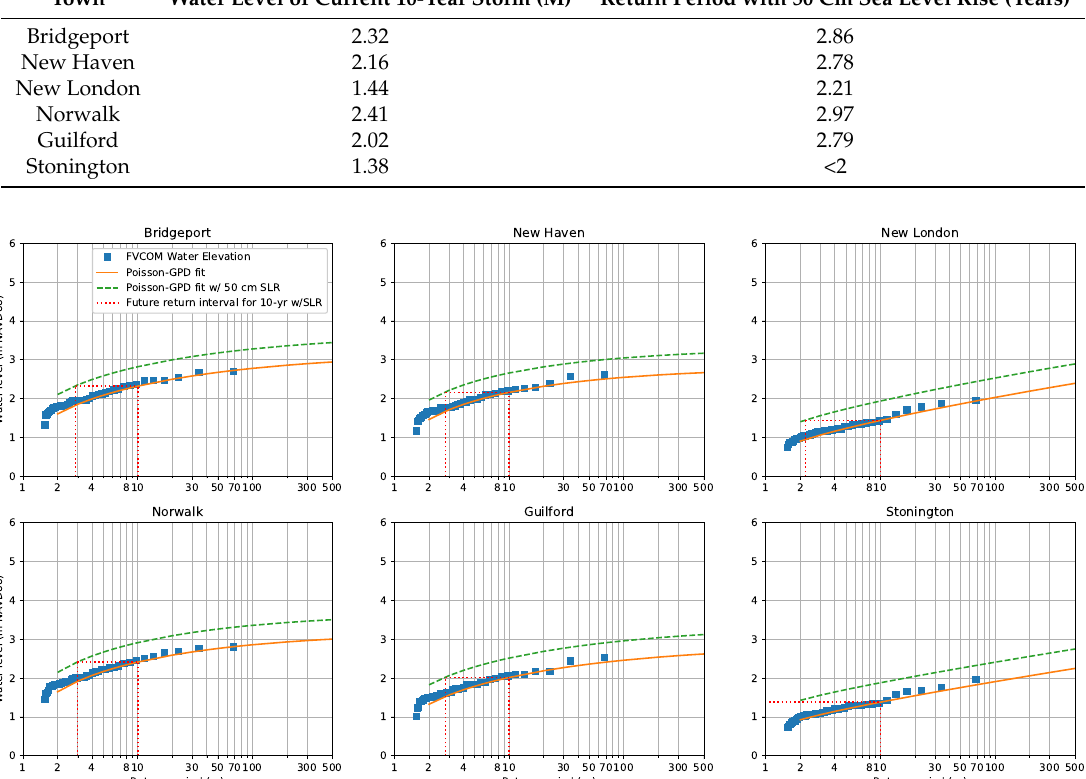
Figure 10. The water level projection for the year 2050 upper bound of 50 cm sea level